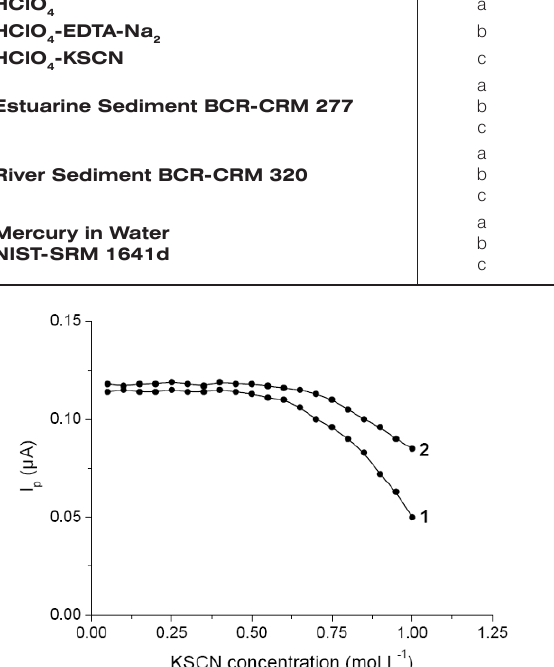
Figure 3. Influence of KSCN concentration on the Hg(II) peak current obtained in DPASV at different HClO Hg(II) concentration: 19.6 μg L -1 . HClO (mol L -1 ): 1.0 (1). 1.0x10 -3 (2); Experimental conditions: see section